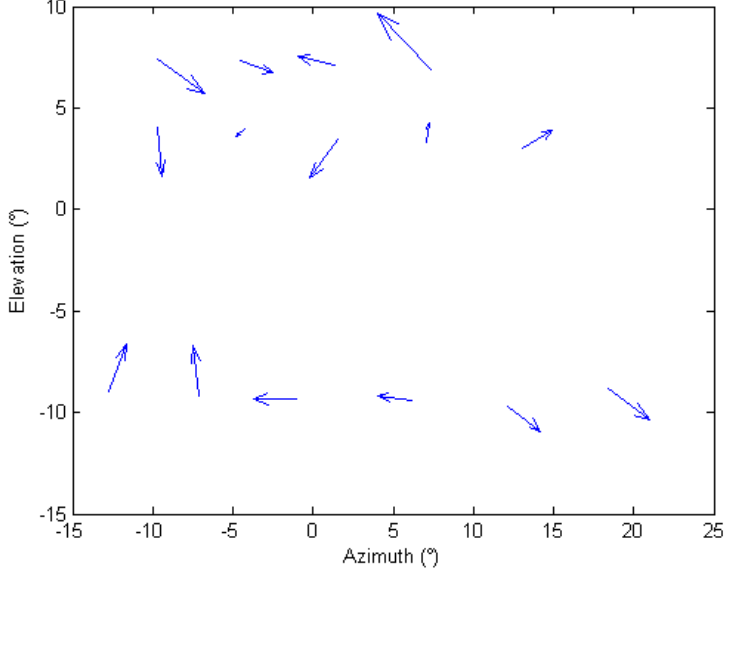
Figure 13. Vector representation of (magnified) azimuth and elevation